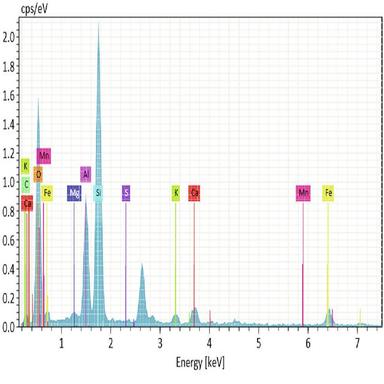
EDS of Sample 3.